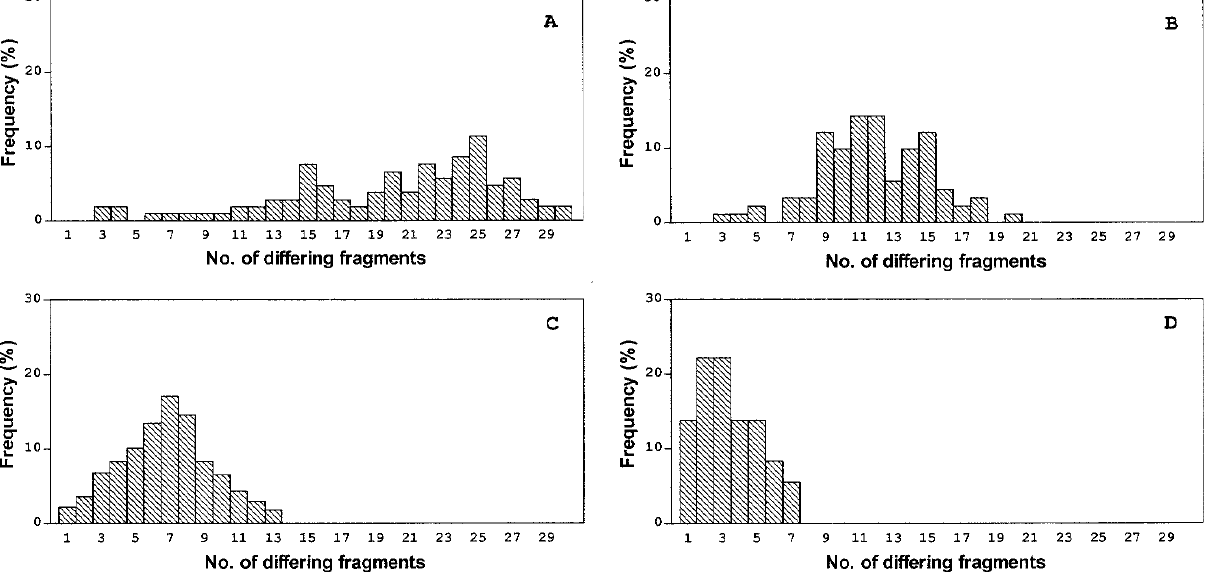
Fig. 2. Frequency of pairwise combinations of multilocus genotypes differing for the number of polymorphic frag- ments. A and B, Phaeoacremonium aleophilum samples, tested with RAPD and RAMS primers respectively; C and D, Phaeomoniella chlamydospora samples, tested with RAPD and RAMS primers